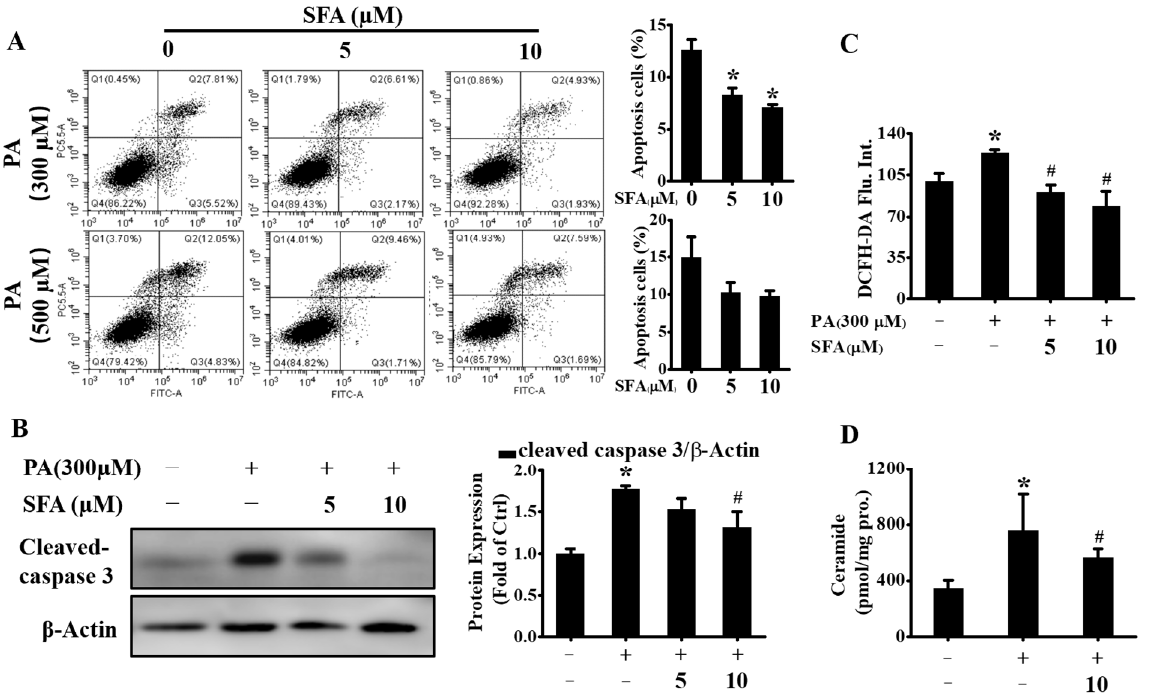
Figure 3. Effects of SFA on alleviating PA-induced apoptosis in HepG2 cells: ( A ) apoptosis detected by annexin V (FITC)/PI staining and the percentage of apoptotic cells was calculated; ( B ) Western blot analysis showed the expressions of cleaved caspase 3 and gray analysis of each band; ( C ) ROS levels evaluated by DCFH-DA staining and expressed as mean fluorescence intensity relative to that in control group; ( D ) total ceramide contents detected by LC/MS/MS. All values are expressed as means ± SD from three independent determinations. * p < 0.05 vs. control cells; # p < 0.05 vs. PA-treated cells.